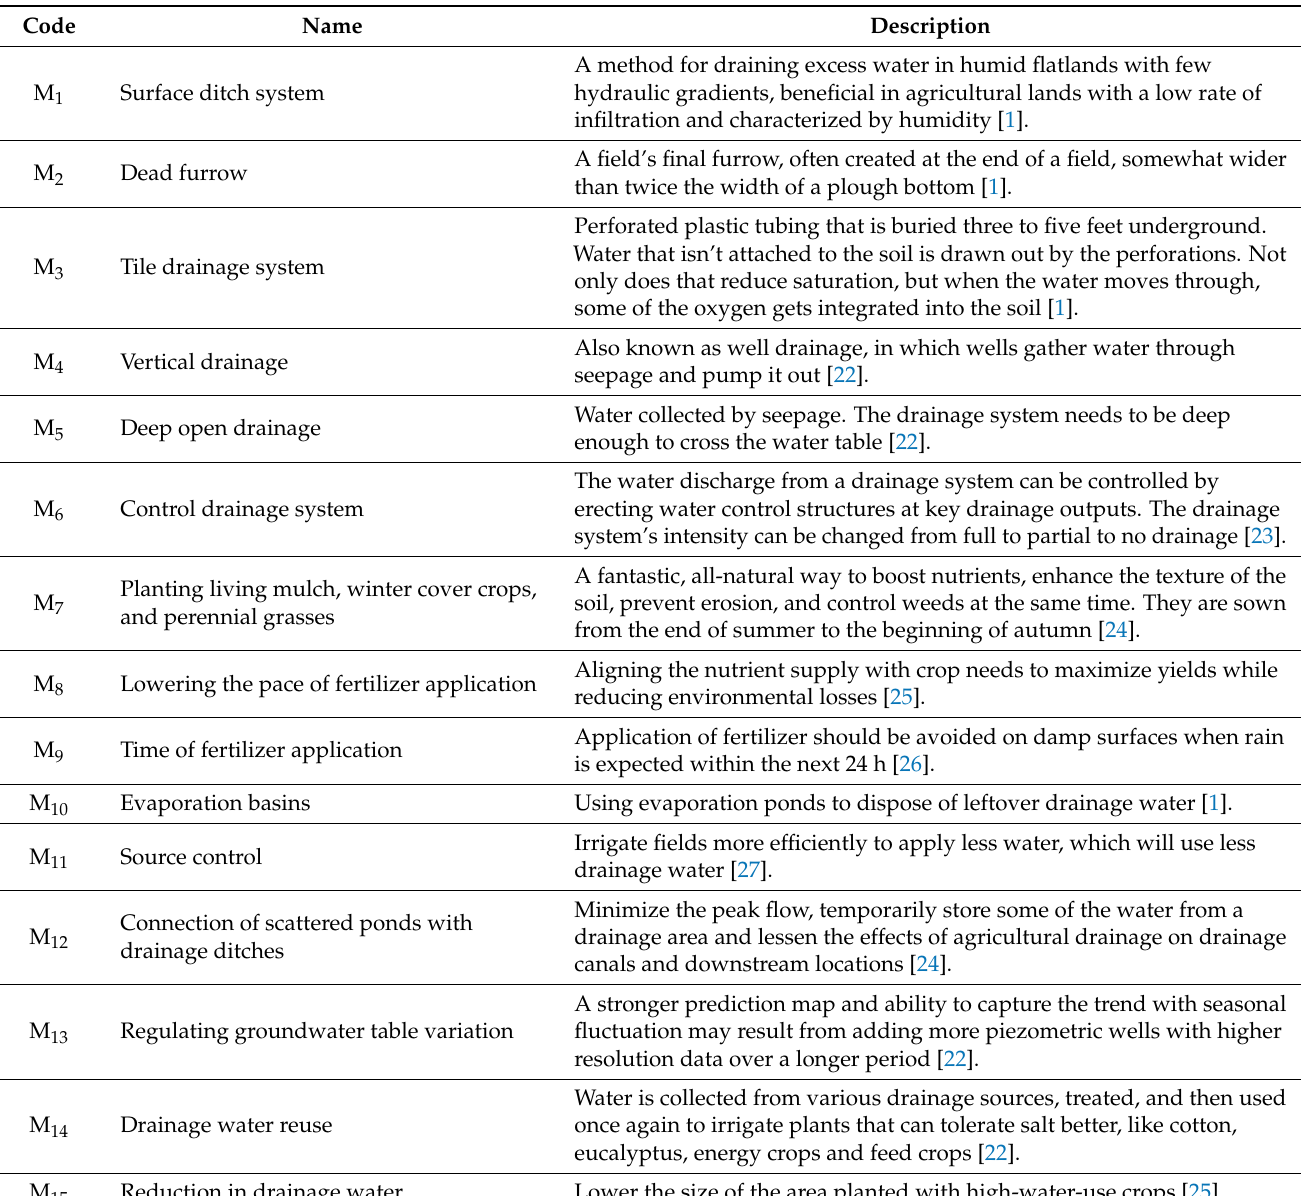
Table 1. Proposed methods for ADWM